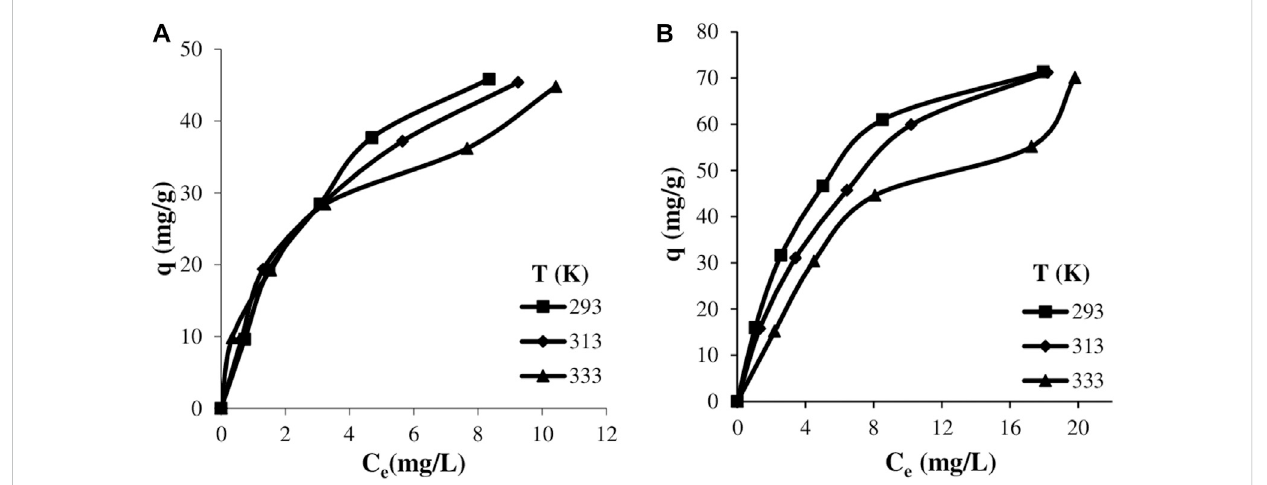
Figure 6 The variation of the amount adsorbed with equilibrium dye concentration for various temperatures: astrazon red (A) and astrazon blue (B) .